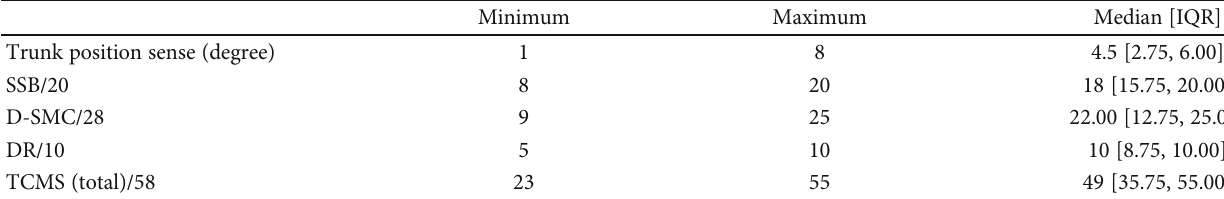
Table 2: Trunk position sense and TCMS mean scores of children with spastic CP.